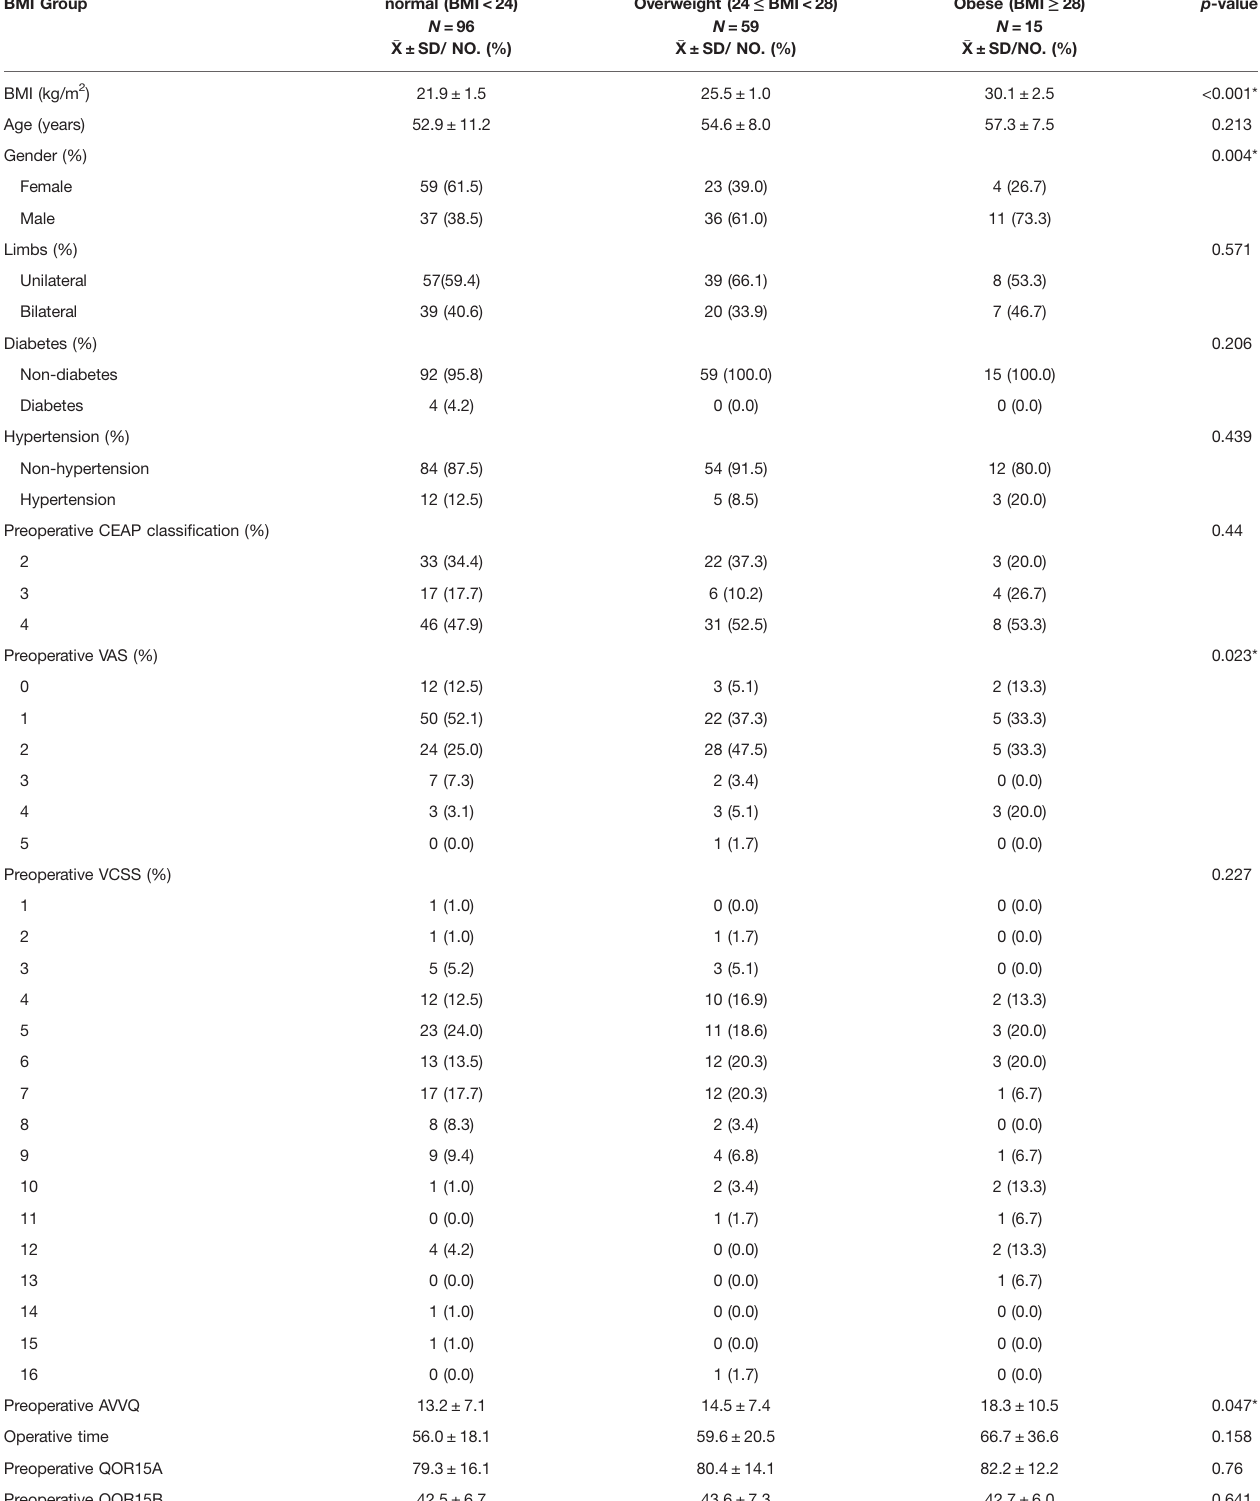
TABLE 1 | Demographics and general characteristics of study participants ( n